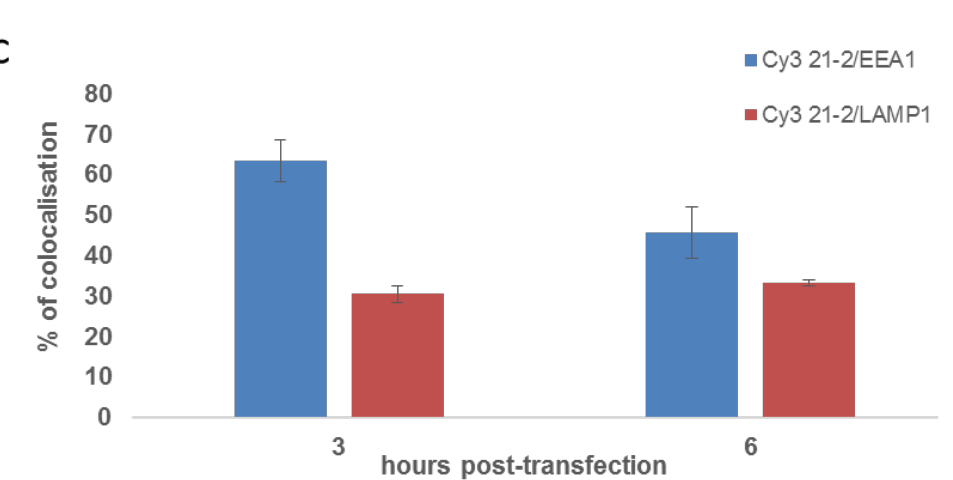
Figure 4. A model aptamer (aptamer 21-2) localises predominantly in early and late endosomes in SiHa cells following Oligofectamine transfection. Cells were transfected with 80 nM Cy3-labelled 21-2 using Oligofectamine. At 3 (Panel ( A )) or 6 h (Panel ( B )) post-transfection, cells were fixed, permeabilised and incubated with primary antibodies anti-EEA1 or anti-LAMP1 (staining early and late endosomes, respectively) prior to incubation with AlexaFluor488 goat anti-rabbit secondary antibody. The right hand side panel is a zoom of merged images. The scale bar = 10 µm. The level of co-localisation was analysed by Bitplane:Imeris image analysis software (Panel ( C )). For EEA1 and LAMP1 colocalisation respectively, n = 8 and 29 at 3 h and n = 30 and 19 at 6 h. Red, green and blue are Cy3 (21-2), FITC (early or late endosomes) and DAPI (nucleus), respectively.